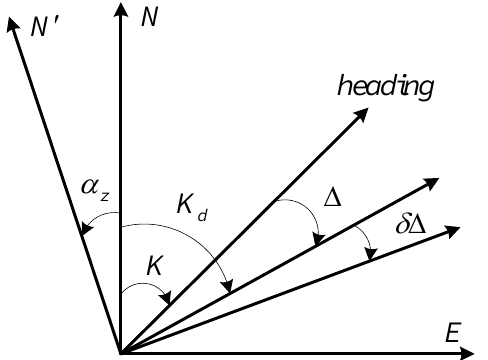
Figure 1. The schematic of the velocity errors measured by the